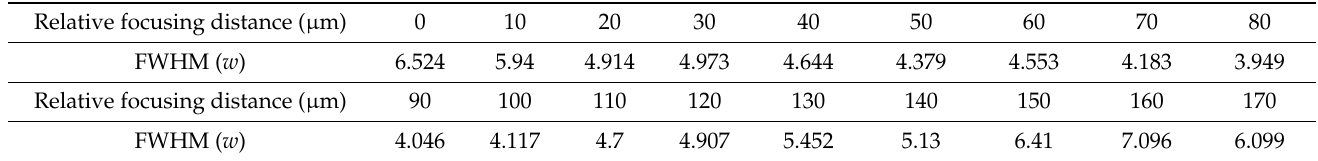
Table 1. FWHM of peak position of 9th ring at different focusing positions.